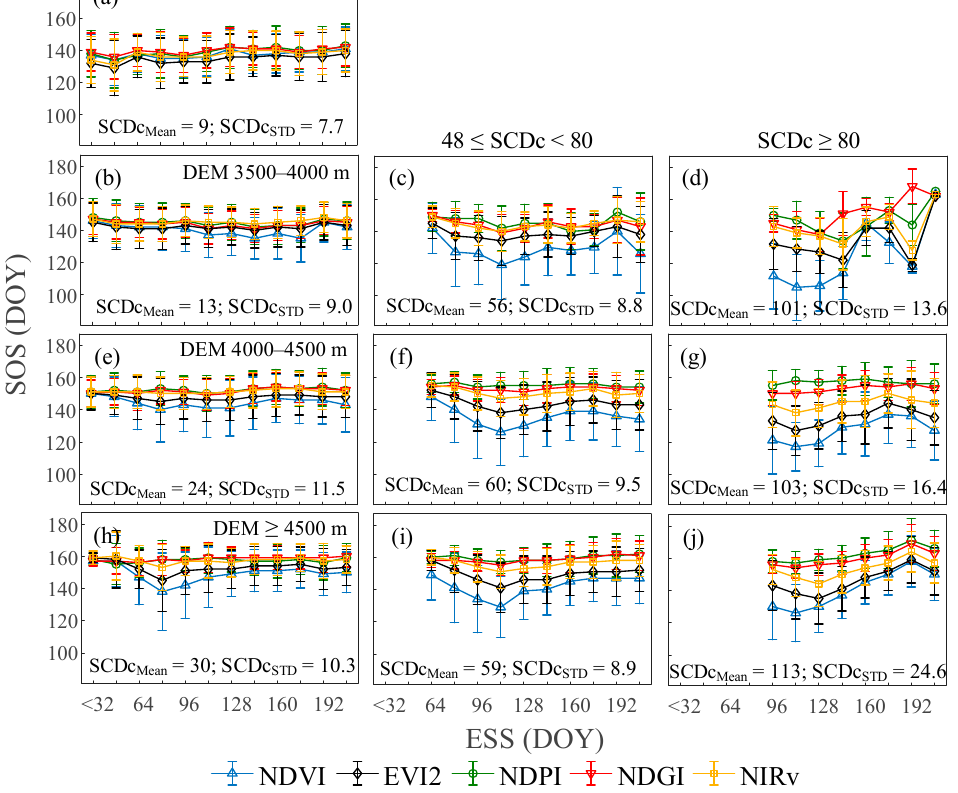
Figure 16. Changes in SOS with increasing ESS under different SCDc cases derived from satellite data. ( a ), ( b – d ), ( e – g ), and ( h – j ) are statistics for elevation zones of DEM < 3500 m, 3500–4000 m, 4000–4500 m, and ≥ 4500 m, in each of which three cases of SCDc < 48, 48 ≤ SCDc < 80, and SCDc ≥ 80 were plotted. SCDc Mean and SCDc STD are the mean and standard deviation of SCDc in each elevation